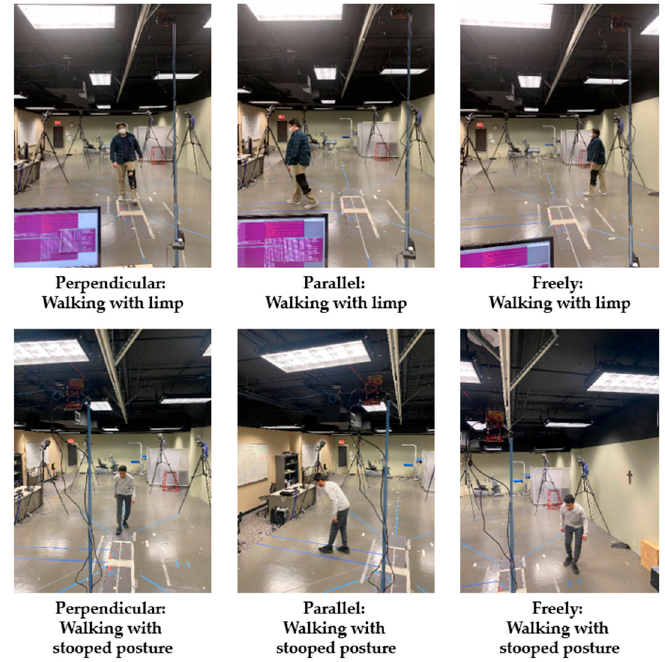
Figure 9. Data collection in the laboratory environment.